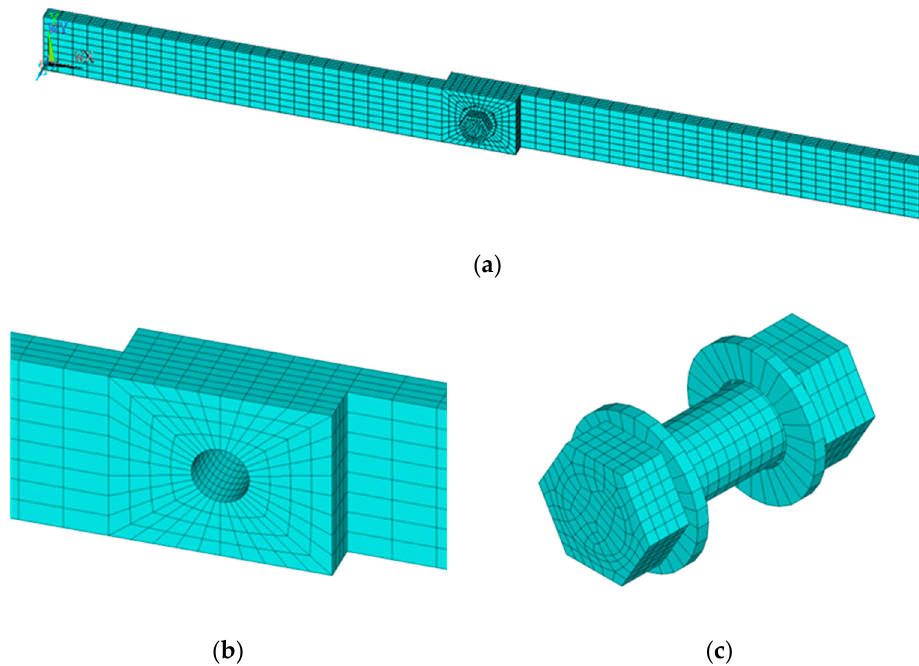
Figure 7. Mesh of the solid FEM model: ( a ) The mesh of the bolt-jointed beam; ( b ) The local mesh of the steel beams; ( c ) The mesh of the bolt, nut and spacers. Table 3. Analysis cases for each mesh density.